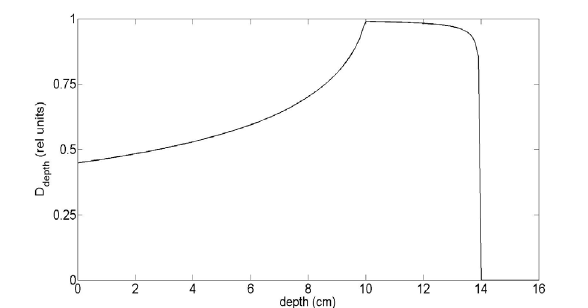
Fig. 5. Lateral distributions as a function of distance from the central axis for various depths d in cm.